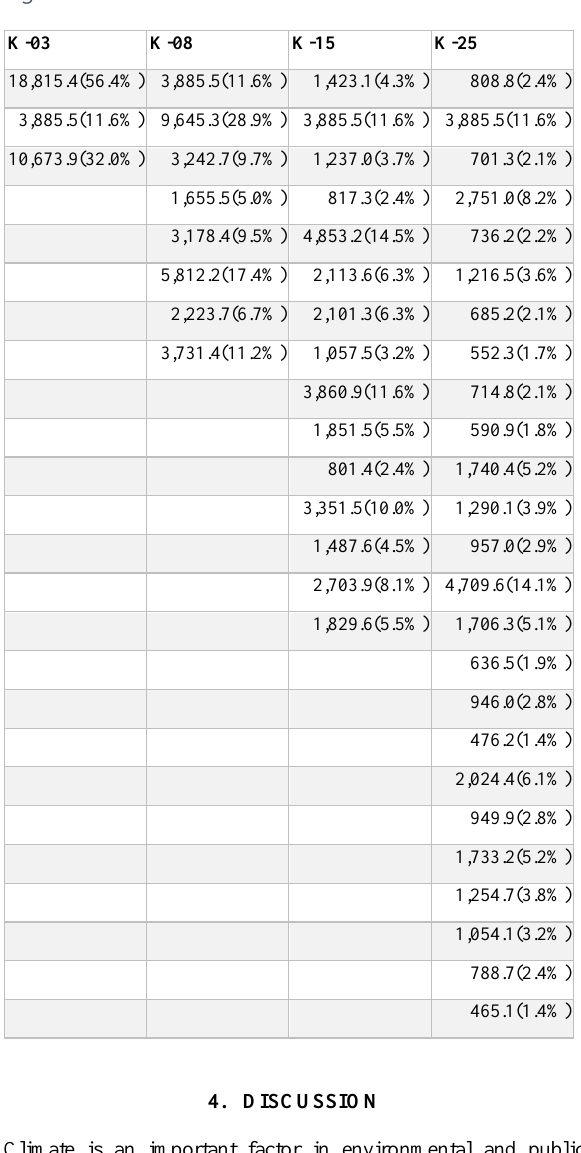
Table 1. Population distribution across 3, 8, 15 and 25 climate